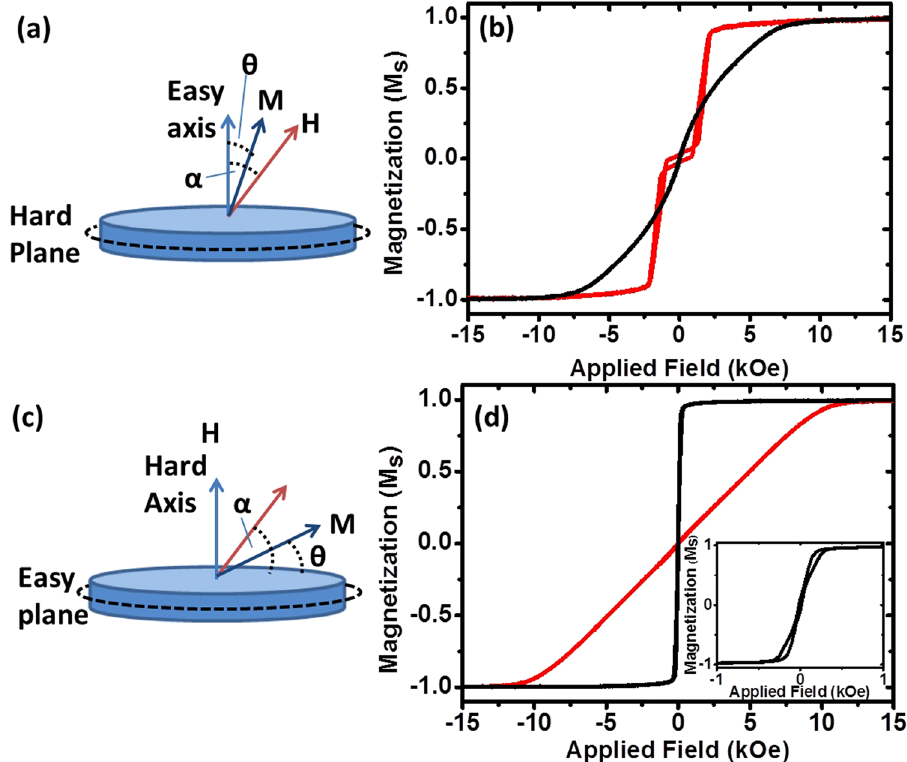
Figure 1. ( a ) Schematic of the angles describing perpendicularly magnetized particles and ( b ) out-of-plane (red) and in-plane (black) hysteresis loops for an array of 2 μ m CoFeB/Pt particles. ( c ) Schematic of the angles describing in-plane magnetized particles and ( d ) out-of-plane (red) and in-plane (black) hysteresis loops for an array of 2 μ m Py vortex particles. The inset in ( d ) is a zoom of the low field region showing the vortex magnetization